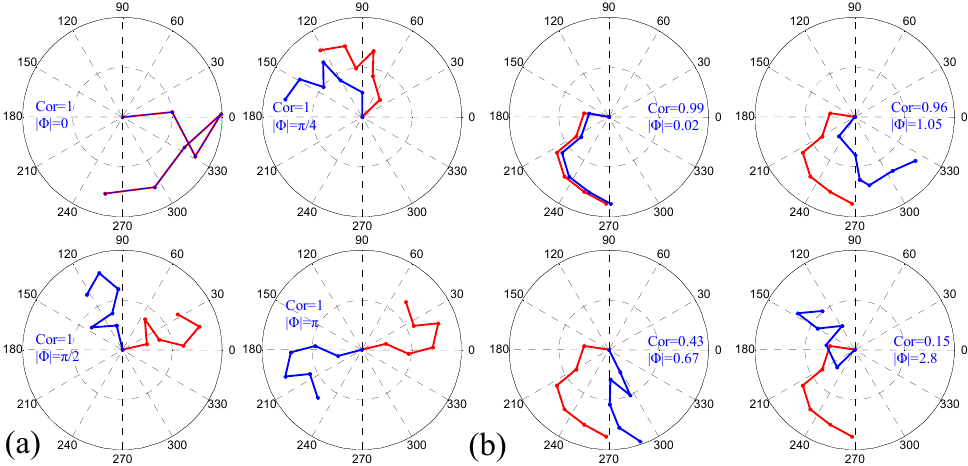
Figure 1. Correlations of complex vectors: ( a ) identical complex vectors with 𝐶𝑜𝑟 = 1 and different rotations, and ( b ) random complex vectors with different 𝐶𝑜𝑟 and rotation | 𝛷 |.